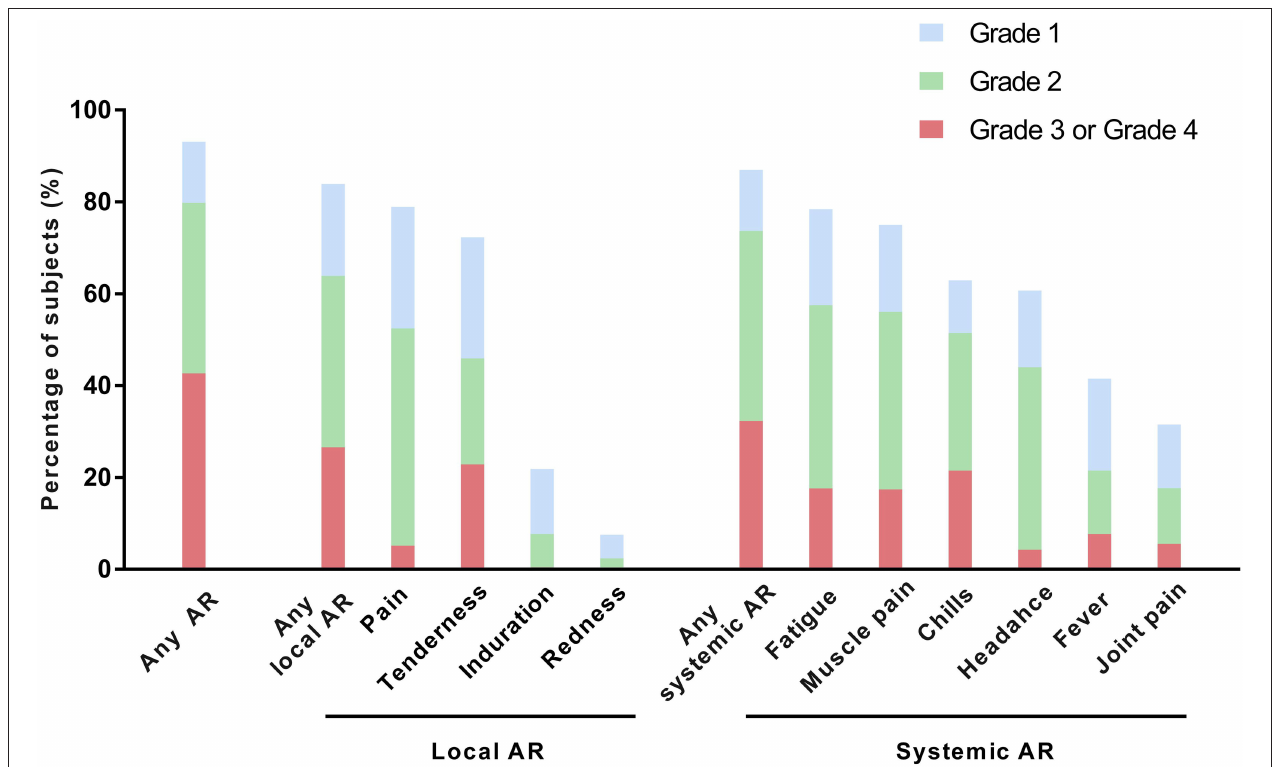
FIGURE 1 | Solicited adverse reactions after the first dose of ChAdOx1 nCoV-19. AR, adverse